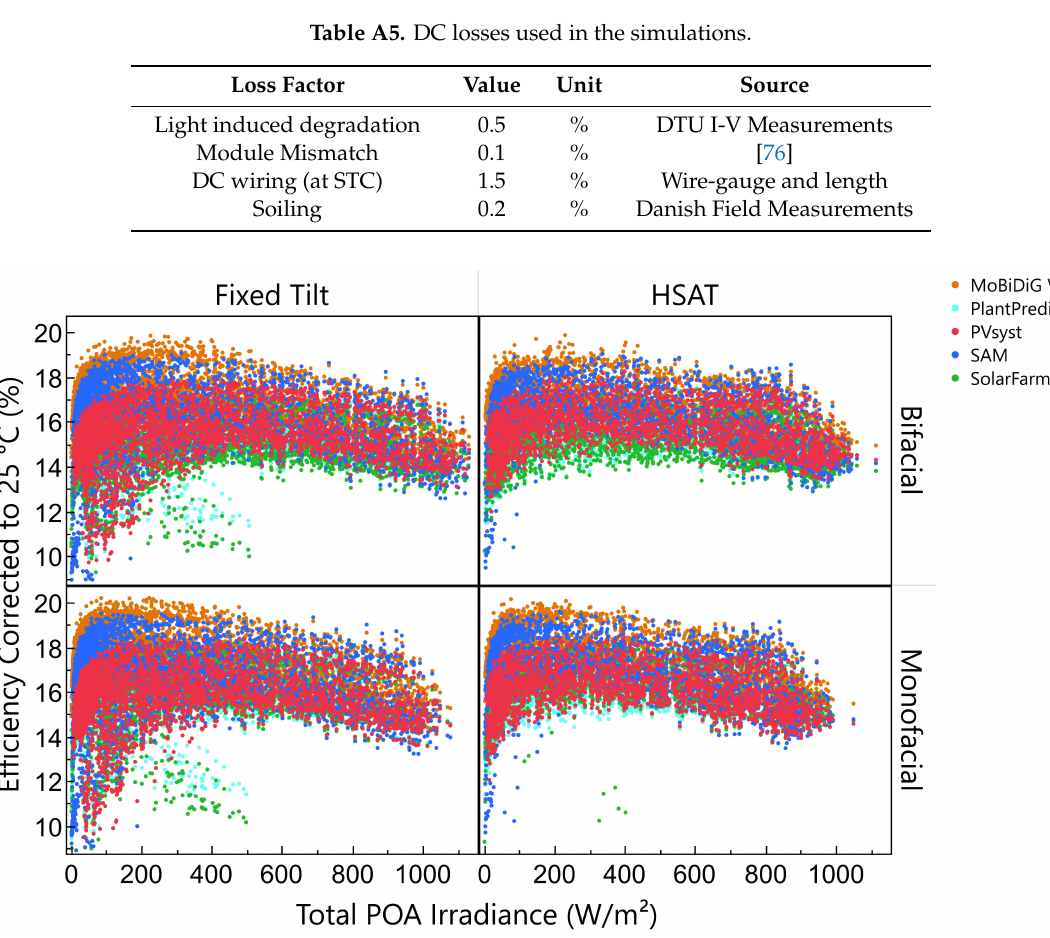
Figure A1. Modeled DC e ffi ciency versus total POA irradiance. Note that in the monofacial cases, the x-axis does not include backside irradiance ( G POA,Rear ). Data are corrected to 25 ◦ C using the module temperature coe ffi cient for P MP